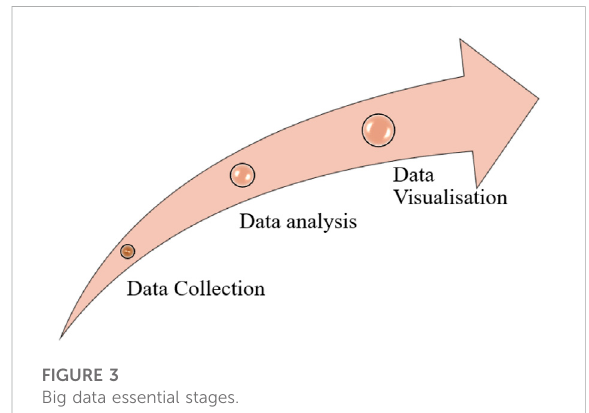
FIGURE 3 Big data essential